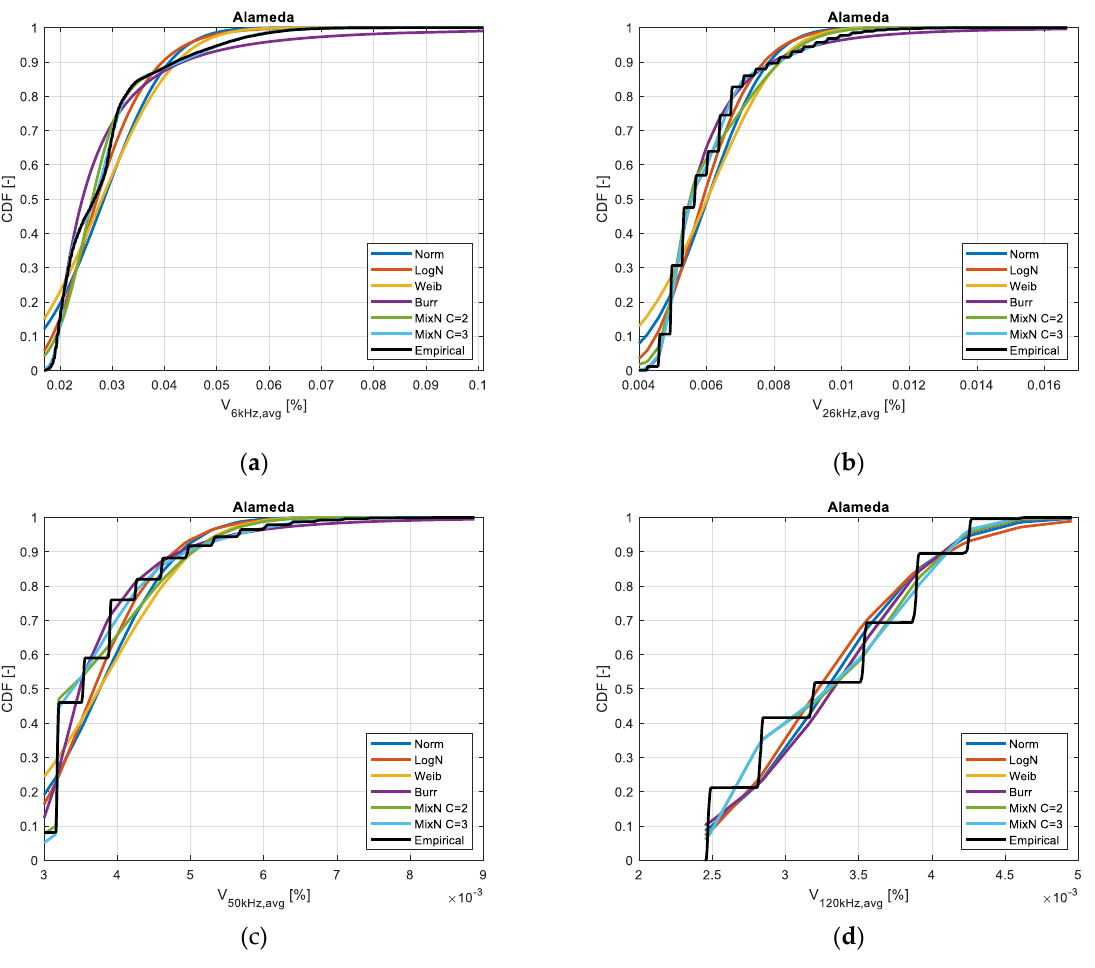
Figure 3. Estimated and empirical CDFs of the: ( a ) 6-kHz; ( b ) 26-kHz; ( c ) 50-kHz; ( d ) 120-kHz avg voltage component at Alameda (CA).